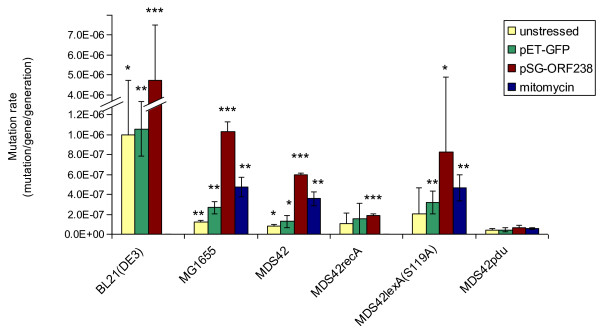
Mutation rates of various strains under unstressed and stressful conditions. Stress conditions include overproduction of GFP, overproduction of a toxic peptide from pSG-ORF238, and treatment with mitomycin-C. All measurements were made using the cycA fluctuation assay, error bars represent 95% confidence intervals for the average of 3 independent measurements. BL21(DE3) and MDS42recA failed to grow in the presence of 0.1 μg/ml mitomycin-C. ANOVA revealed a significance of p < 0.0001. Pairwise t-tests were conducted for each strain under a given condition compared to the corresponding MDS42pdu strain, * indicates a significance of p < 0.05, ** indicates a significance of p < 0.01, *** indicates a significance of p < 0.001.